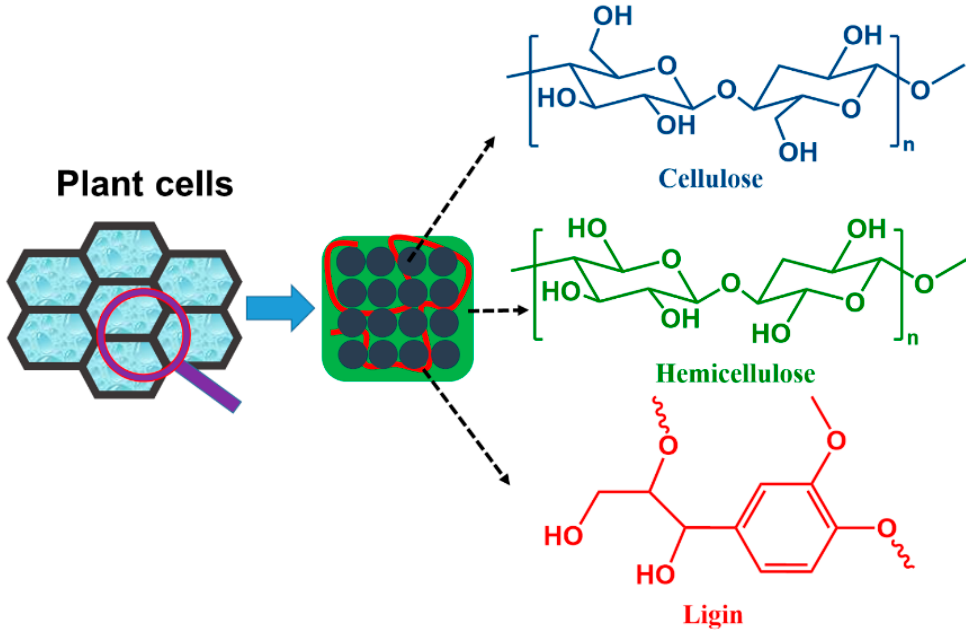
Figure 1. The three most common components contained in plant cell walls: cellulose, hemicellulose, and lignin, collectively known as lignocellulose.